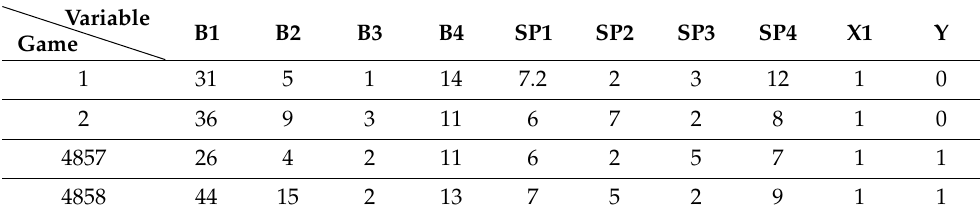
Table 2. MLB variable table (dataset